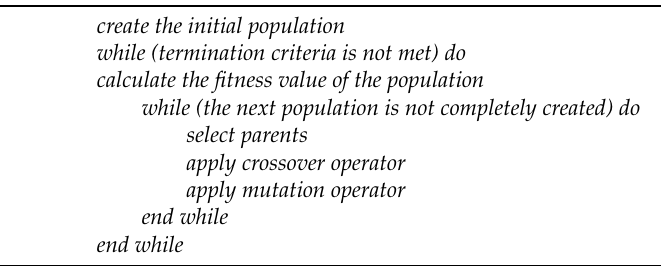
Table 2. Pseudo-code of the genetic